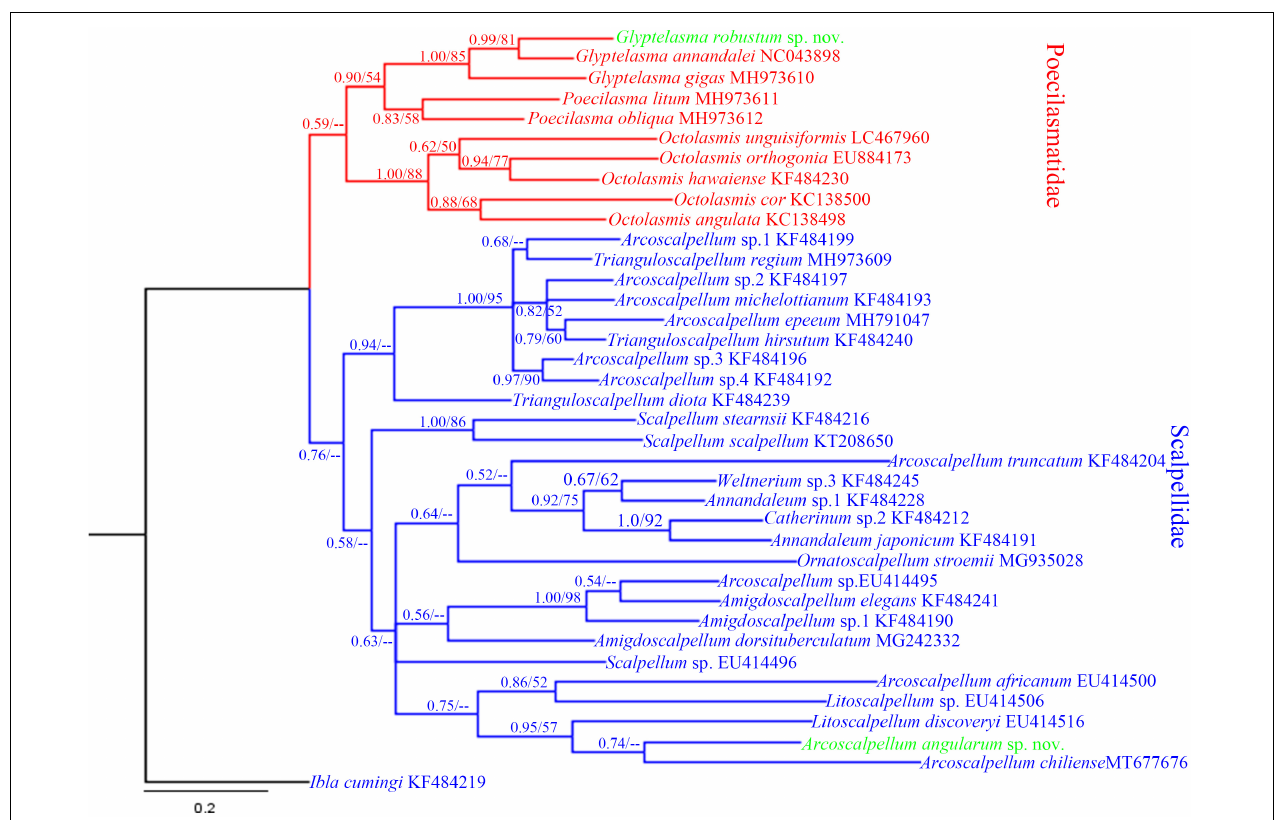
FIGURE 8 | Bayesian inference tree recovered from COI sequence data. Numbers at nodes represent posterior probabilities/bootstrap values, and numbers less than 0.50 or 50 are shown as